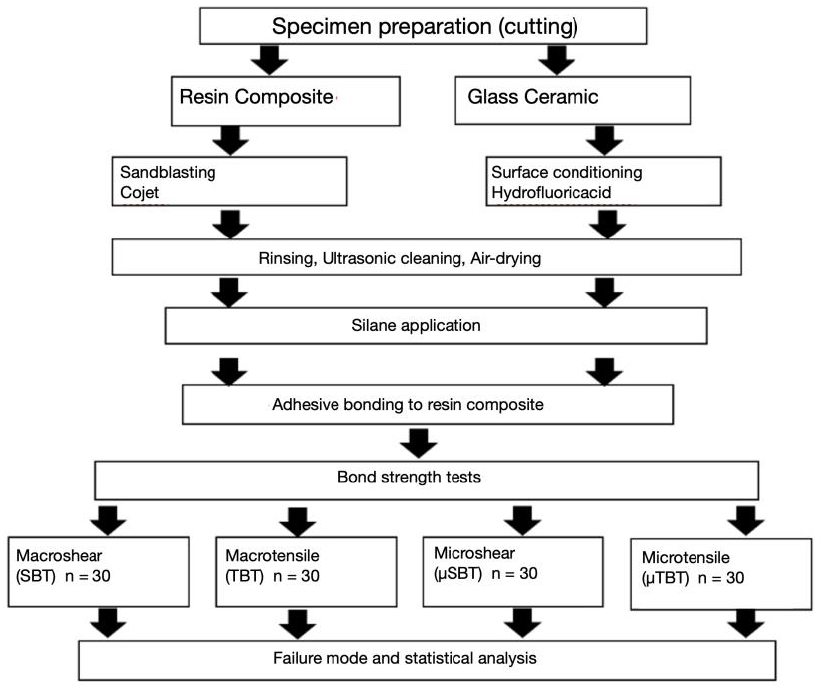
Figure 1. Experimental flowchart presenting distribution of the tested groups according to the testing method, substrate, and procedure sequences of the experiment. SBT: Macroshear, TBT: macrotensile, µ SBT: microshear and µ TBT: microtensile.